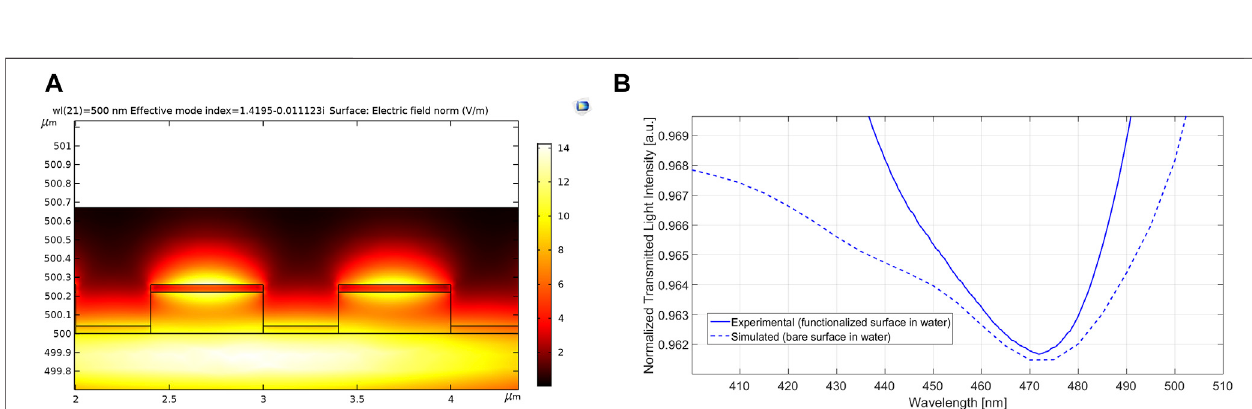
Figure 2 , where we have also reported an outline of the cross- section together with the SEM image of the fabricated gold nanograting. The dimensions of the GNG are reported in Figure 2A ; the pattern showed a bulk sensitivity value of about a half that obtained by an optimized pattern and reported in (Arcadio et al., 2021b).